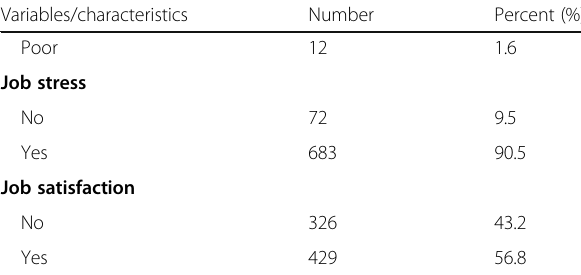
Table 3 Working environment, ergonomic characteristics,